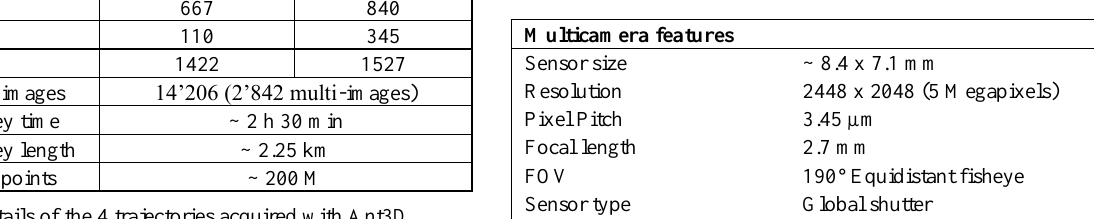
Figure 5. Portion of the point cloud obtained with Ant3D, raw output (top) and filtered output (centre). At the bottom there is a visualisation of the confidence filter applied in Metashape.